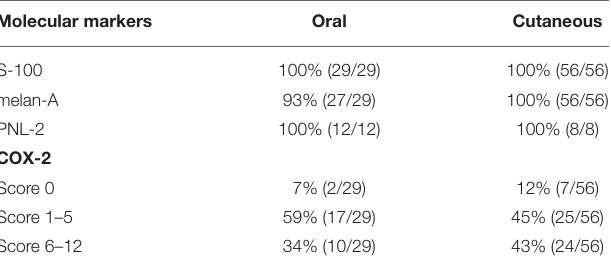
TABLE 4 | Immunohistochemical positivity of oral and cutaneous melanomas by S-100, melan-A, PNL-2, and COX-2 antibodies. Molecular markers Oral